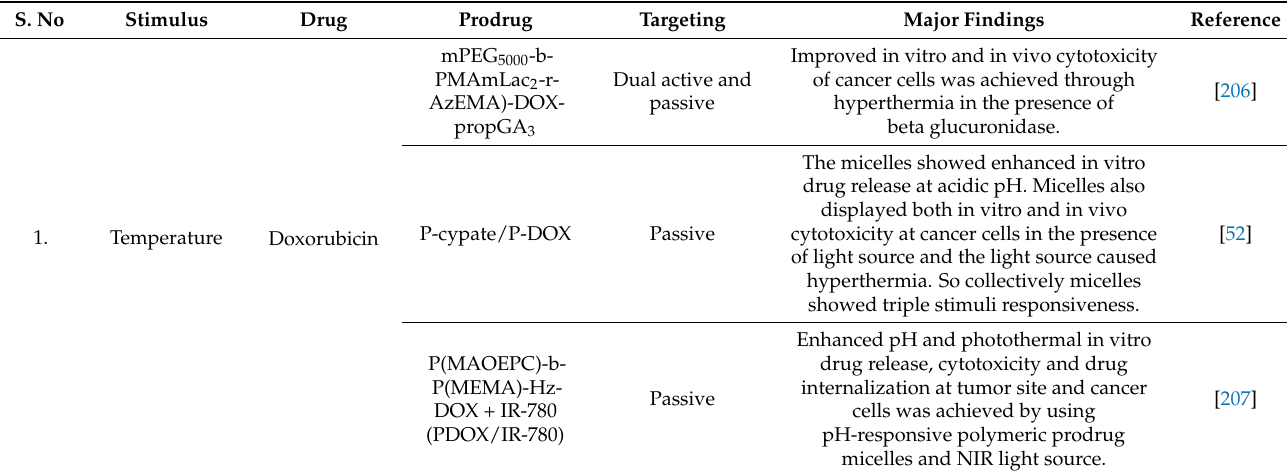
Table 6. Stimuli-Responsive Prodrugs for Cancer